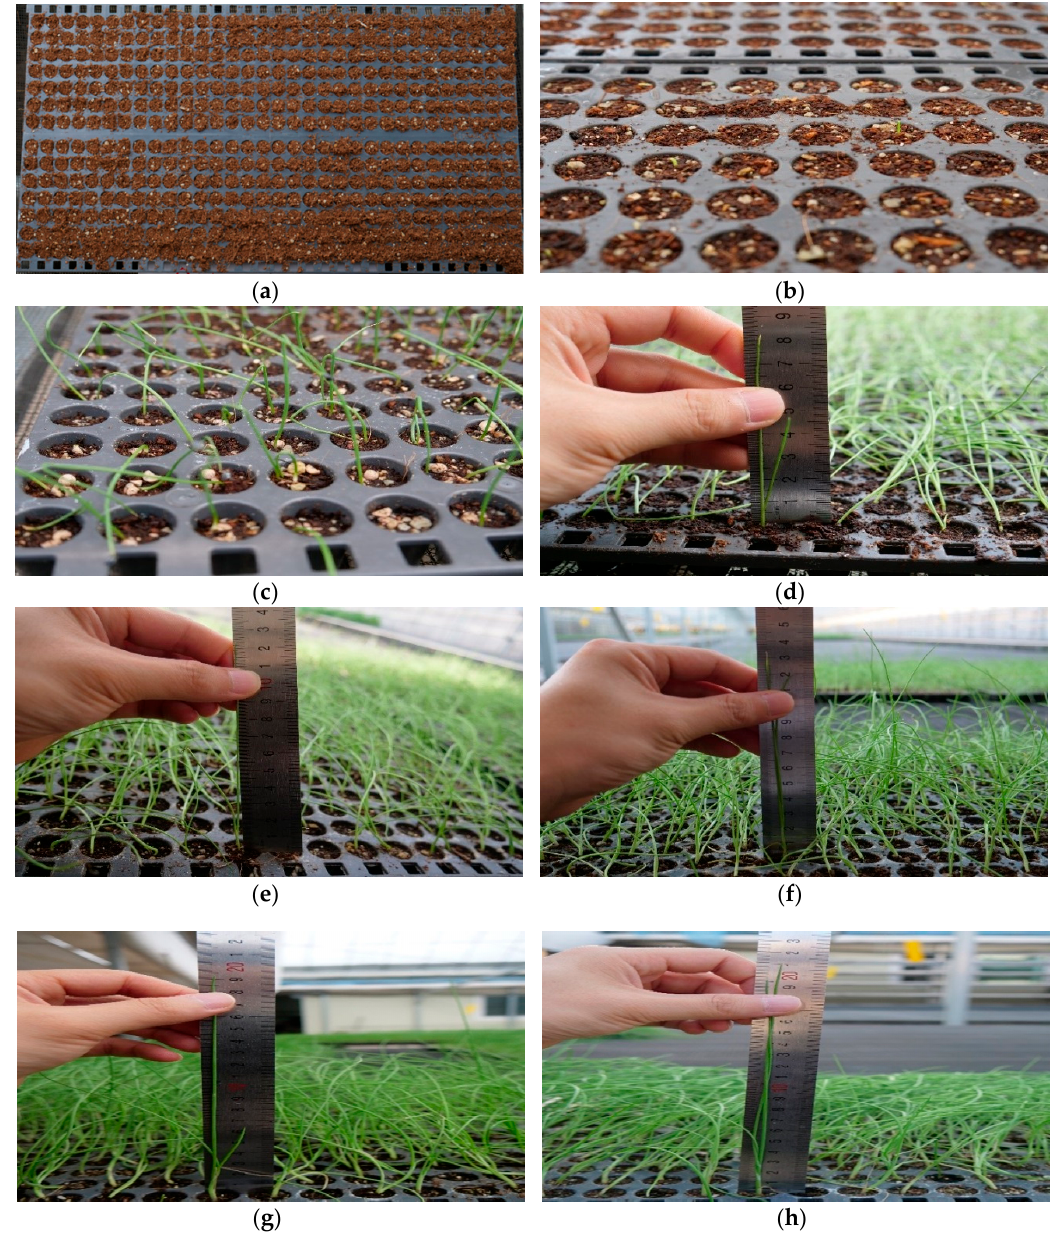
Figure 13. Growth status of onion seedlings: ( a ) Week 1; ( b ) Week 2; ( c ) Week 3; ( d ) Week 4; ( e ) Week 5; ( f ) Week 6; ( g ) Week 7; ( h ) Week 8. Table 13. The onion seedling growth states for both